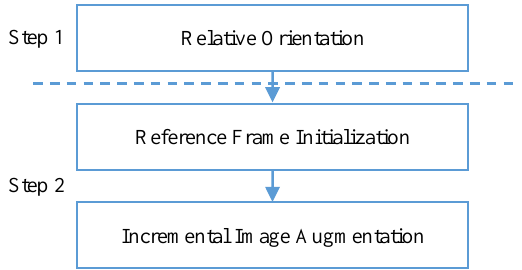
Figure 1. The proposed workflow for initial recovery of the image EOPs